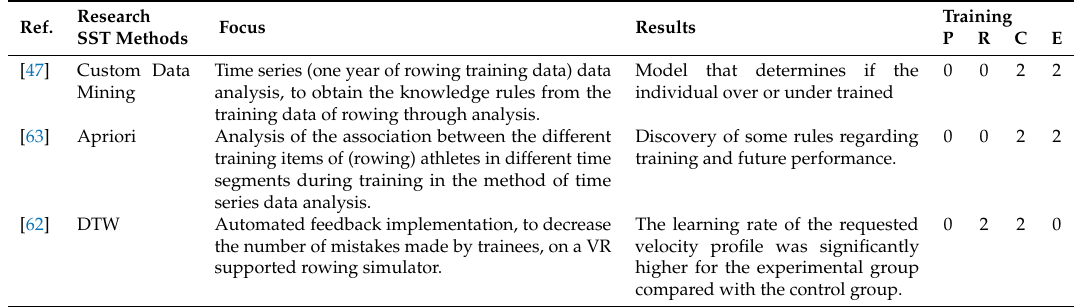
Table 8. Identified studies in the domain of